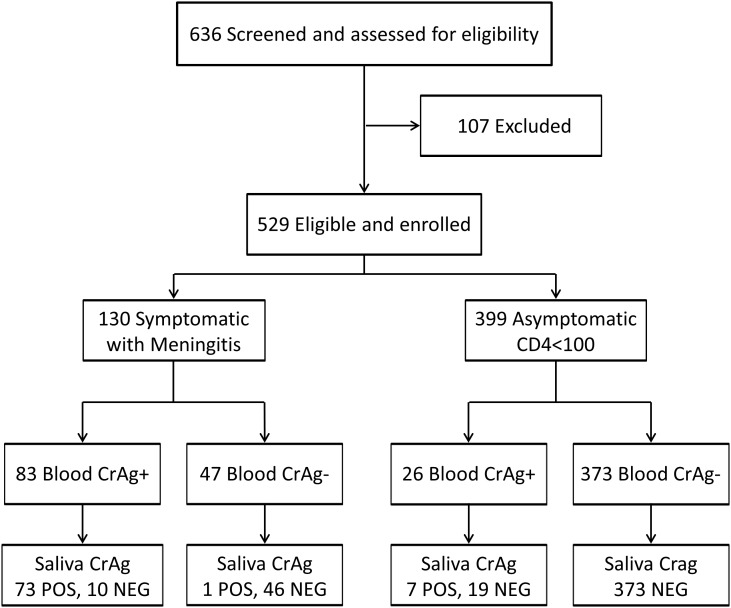
The Study enrollment and Analysis populations.The figure displays the distribution of the participants tested, consisting of HIV-infected persons from: 1) symptomatic meningitis cohort or 2) asymptomatic outpatient cohort with CD4<100 cells/µL. Saliva cryptococcal antigen (CrAg) lateral flow assay performance was compared with the reference standard of cryptococcal antigenemia in peripheral blood (i.e. CrAg+ in serum or plasma). The level of agreement between the two sample types is better in symptomatic patients (κ = 0.82) than in asymptomatic patients (κ = 0.41).